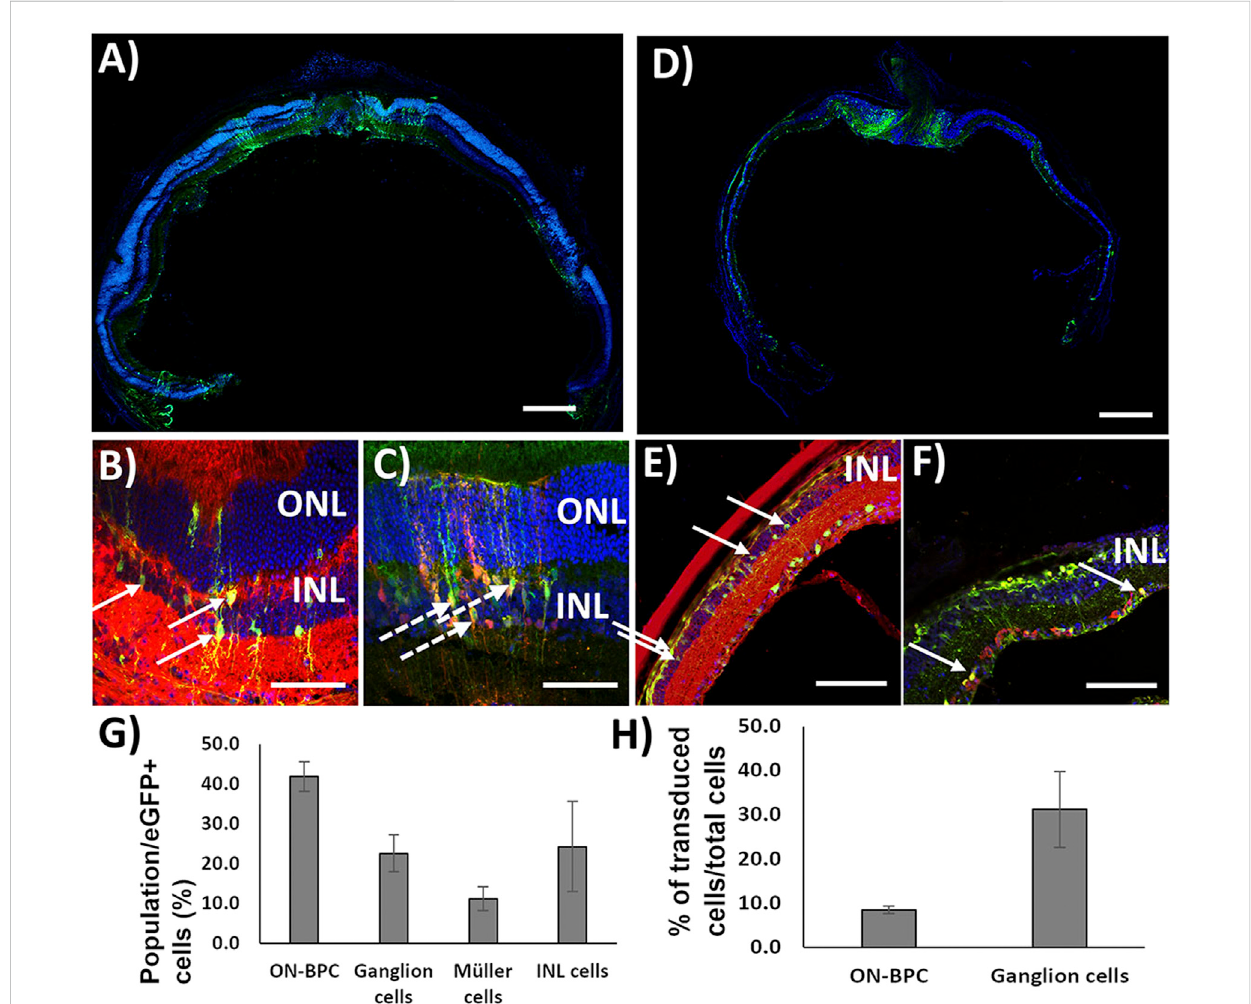
FIGURE 3 Exo-AAV1 ef fi ciently transduces inner retinal cells upon intravitreal injection. (A – C) Representative confocal micrographs of retinal cryosections from C57BL/6 mice injected with Exo-AAV1 mixtures of virions expressing eGFP and TurboFP635, respectively, under the CMV ubiquitous promoter. (A) Talescans ofthewholeretinalabeledwith thenuclearstain DAPIandagainst eGFP; (B) sectionlabeledagainsteGFP,G0 α (ON-BPC speci fi cmarker),and DAPI; (C) section with natural eGFP fl uorescence, anti-TurboFP635, and DAPI staining. (D – F) Representative confocal micrographs of retinal cryosections from rd1 mice injected with Exo-AAV1 mixtures of virions expressing eGFP and TurboFP635, respectively, under the CMV ubiquitous promoter. (D) Tale scans of the whole retina labeled with the nuclear stain DAPI and against eGFP; (E) section labeled against eGFP, G0 α (ON-BPC- speci fi c marker), and DAPI; (F) section labeled against eGFP, RMBP (ganglion cell-speci fi c marker), and DAPI. (G) Quanti fi cation of cell-type-speci fi c transduction. INL represents inner nuclear layer cells which are not ON-BPCs, e.g., OFF-BPCs, horizontal cells, and amacrine cells. (H) Quanti fi cation of the transduction ef fi ciency in ON-BPCs and RGCs. ONL, outer nuclear layer; INL, inner nuclear layer. Full arrows indicate cells double stained for eGFP andG α o (B,E) andeGFPandRBPMS (F) .DashedarrowsindicatecellsdoublestainedforeGFPandTurboFP635.Scalebar200 μ m (A,D) ,50 μ m (B,C) ,and 10 μ m (E, F)